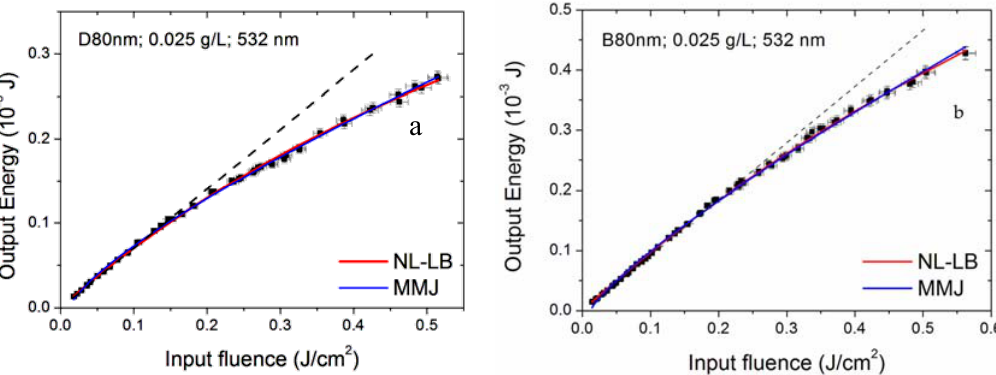
Figure 17. ( a , b ) Examples of optical limiting data allowing fitting by both models. The linearity regime (dashed black line) is also reported for enhanced visualization.